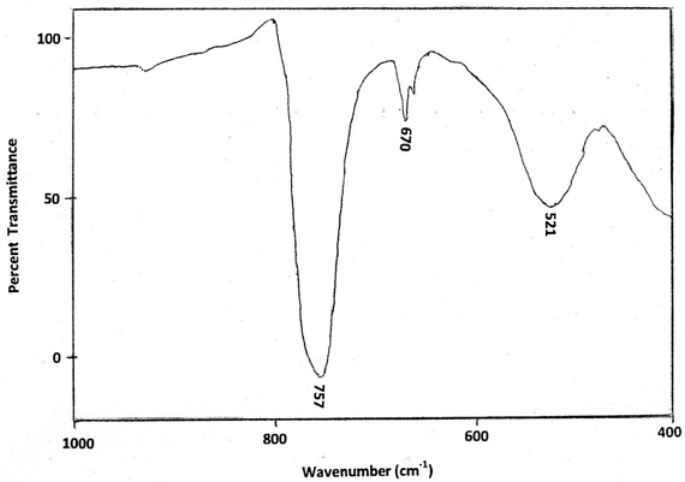
Figure 6. IR spectrum of poly(methyl methylacrylate)